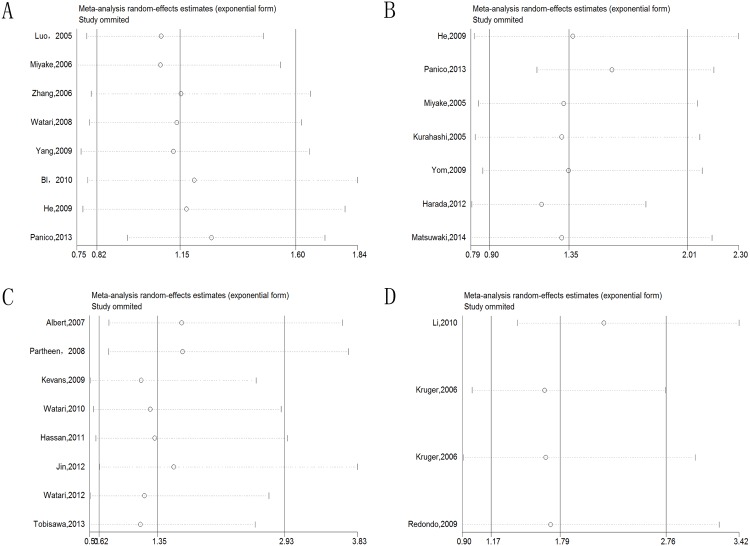
Sensitivity of each included study in three different groups.(A) Sensitivity analysis of OS in group 1. (B) Sensitivity analysis of RFS in group 1. (C) Sensitivity analysis of OS in group 2. (D) Sensitivity analysis of RFS in group3.